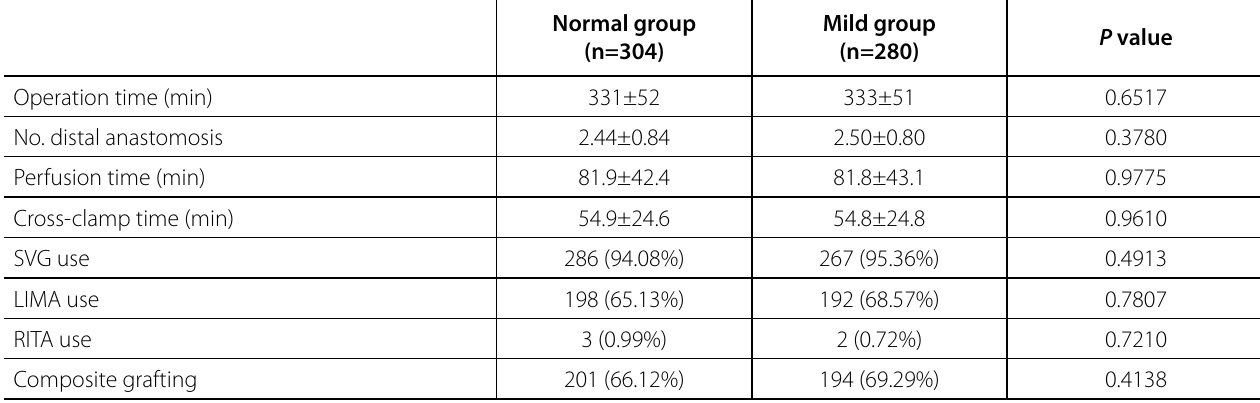
Table 2. Intraoperative data.